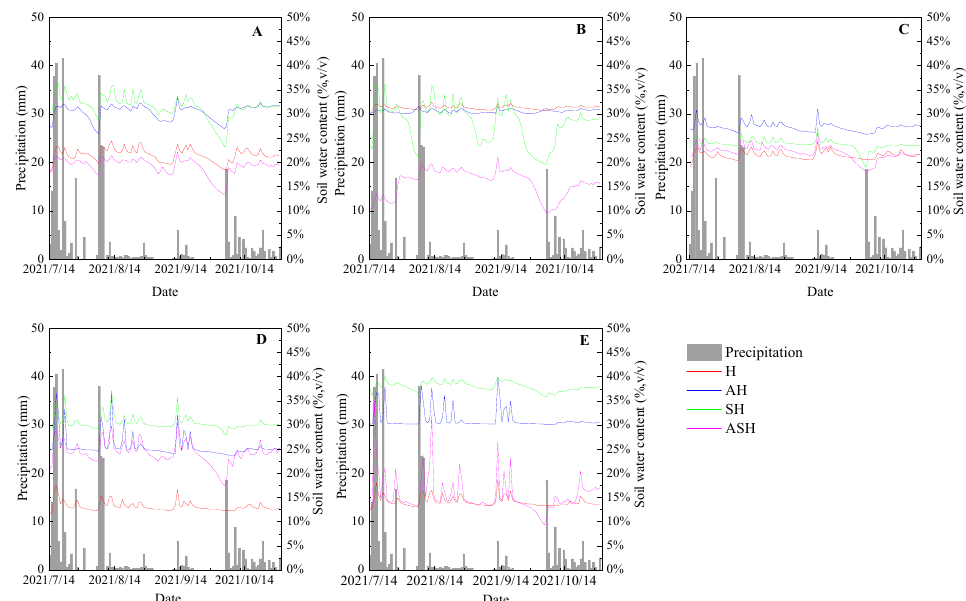
Figure 4. Daily variations of soil moisture content for 0–70 cm. ( A ) 0–10 cm, ( B ) 10–20 cm, ( C ) 20–30 cm, ( D ) 30–50 cm, ( E ) 50–70 cm.